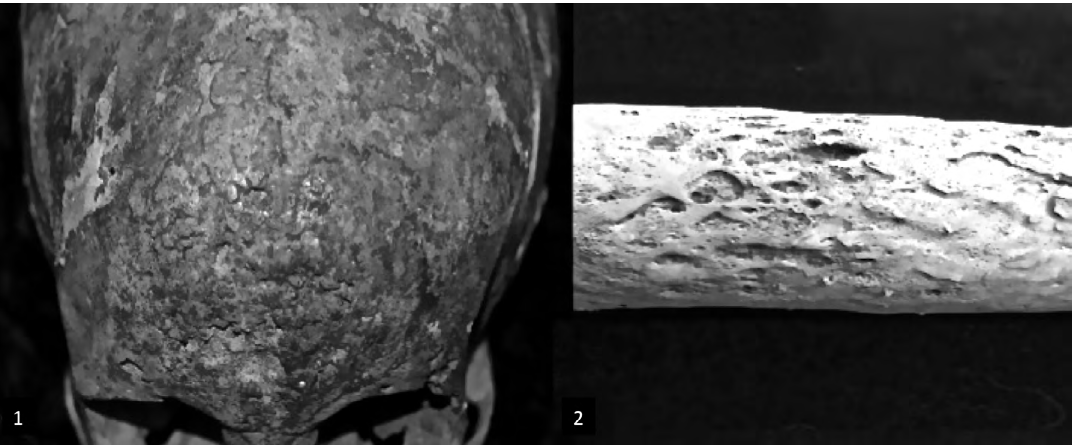
Figure 2 . Macroscopic lesions suggestive of or specific to syphilis. 1. Cranium demonstrating stages three to six of the caries sicca sequence. 2. Femur demonstrating nodes and expansions with superficial